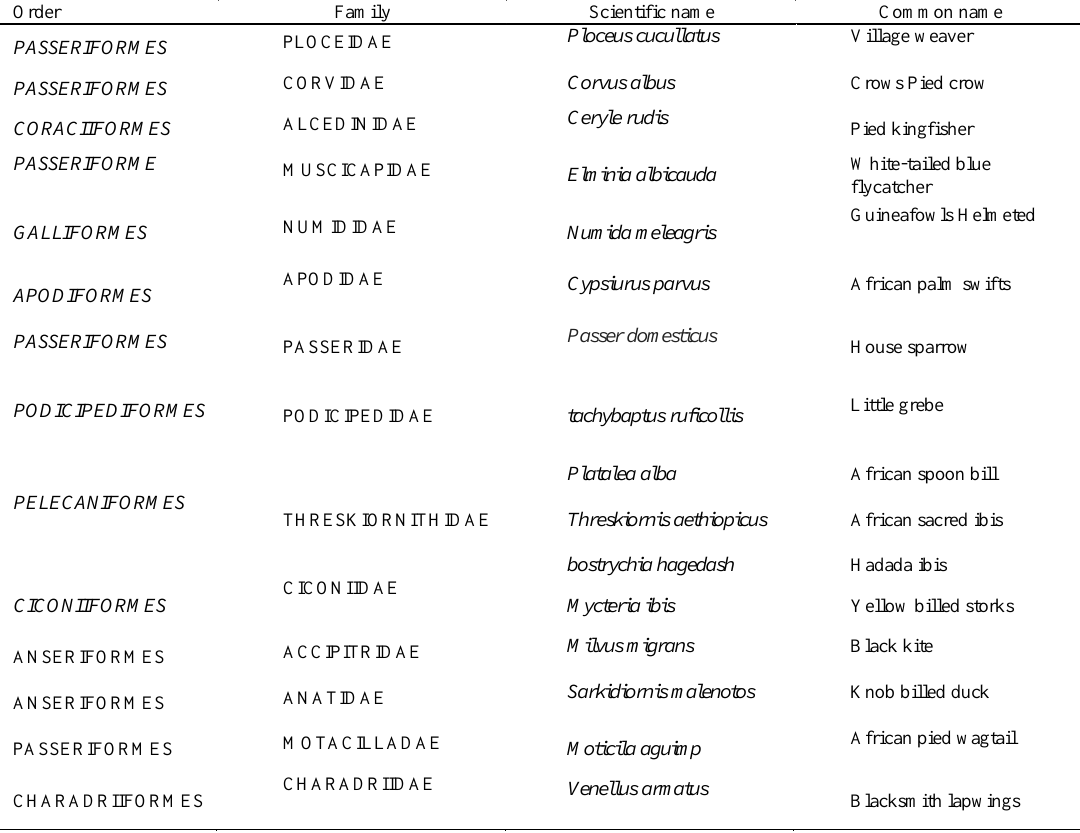
Table 1: Scientific Checklist of birds which were observed on Dumpsite and Sewage stabilization pond on April